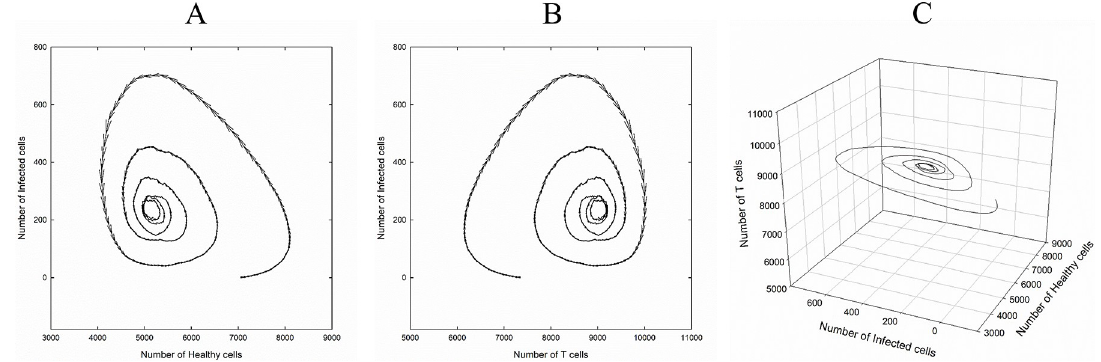
Fig 12. Total number of different cell types as a vector graph for the case of P I = 1, P T = 0.4, P H = 0.4, and P D = 0.01. Vector direction shows temporal evolution while vector magnitude demonstrates variation amount: A) The number of infected versus the number of healthy cells, B) The number of infected versus the number of T cells. C) a 3-dimentional graph of the number of infected cells versus the number of healthy and T cells.